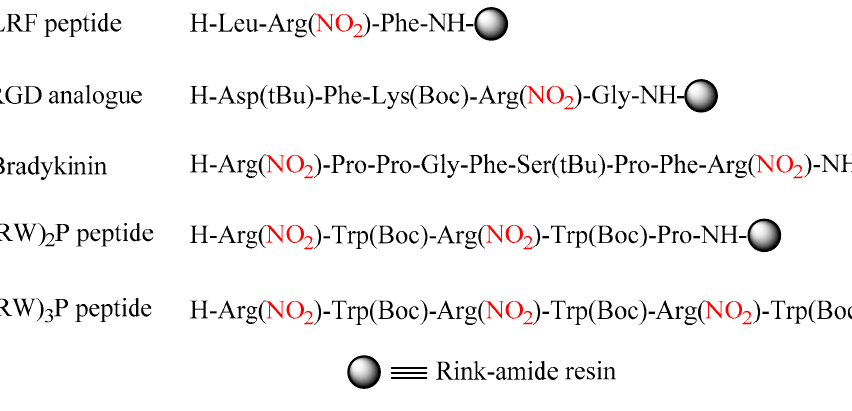
Figure 4. Peptidyl resins used in this study.